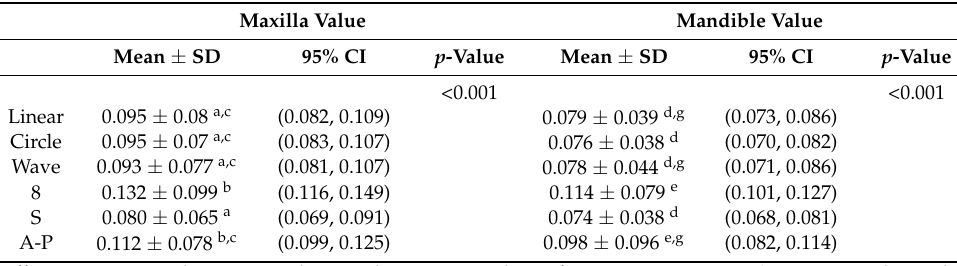
Table 1. Mean absolute deviations of maxilla and mandible occlusal side (mm).